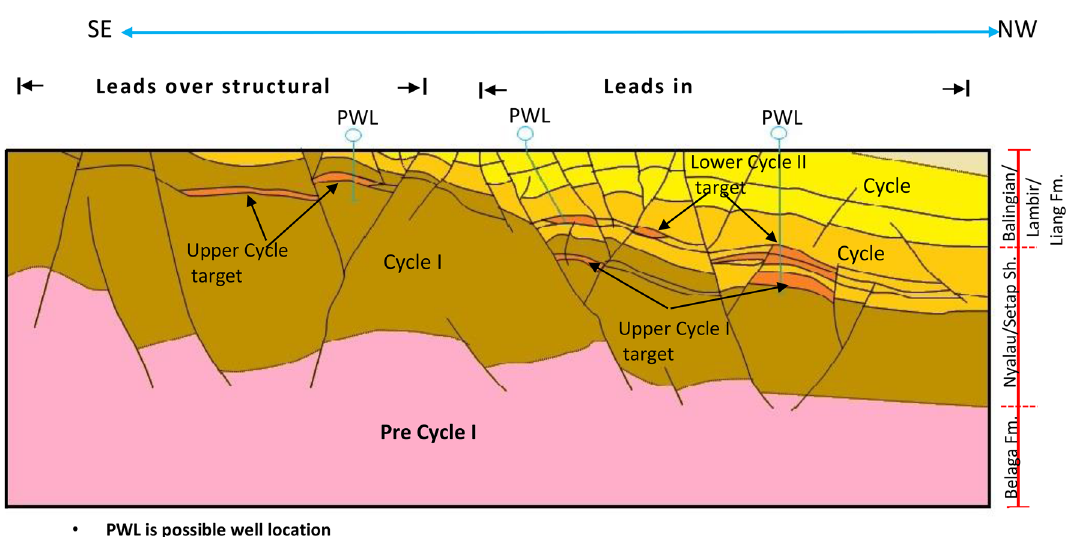
Fig. 14 Overview of trapping models in Tinjar Province Modified after Ismail and Abu Hassan (1999)